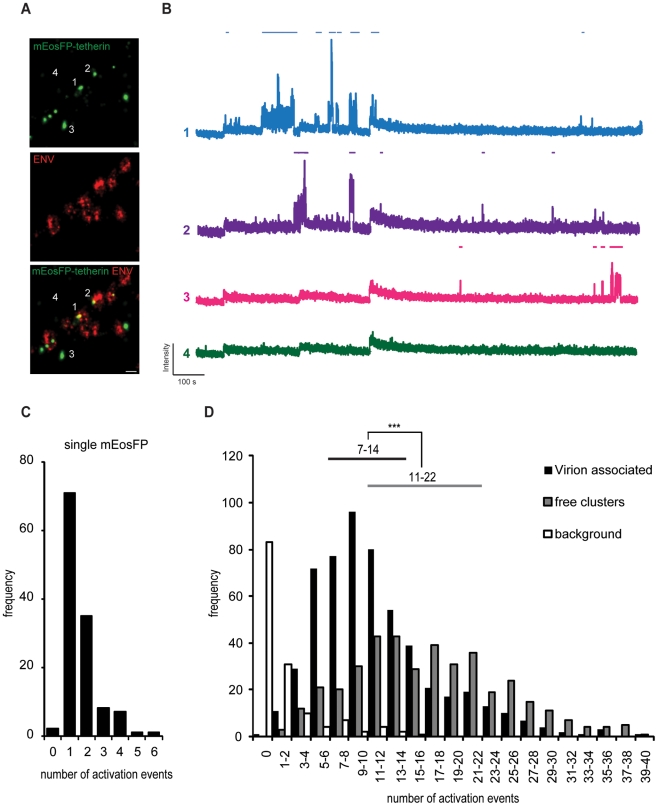
Single fluorescent molecule quantification of mEosFP-tetherin at HIV-1 budding sites.(A) Representative region of super-resolution images of HeLa cells transfected with HIV-1 Δvpu and mEosFP-tetherin and stained by indirect immunofluorescence for HIV-1 ENV. Acquisition was performed under alternating 561 and 644 nm excitation and continuous 405 nm photoactivation for 15 000 frames, scale bar 200 nm. (B) Intensity traces of single mEosFP-tetherin clusters as depicted in (A). Automated detection of activation events on top of each trace is depicted using a threshold of 10 standard deviations above background and a dark time of 5 s. (C) Histogram of number of activation events per single mEosFP molecules in 1% PVA (n = 125). (D) Histogram of number of activation events of mEosFP-tetherin molecules in free clusters (n = 400) or clusters that are associated with HIV-1 budding sites (n = 550) in 5 cells. Background was selected in regions without clusters. Range indicates 25th–75th percentile. *** indicates statistically significant difference with p<0.001 (two-tailed paired Student's t-test).